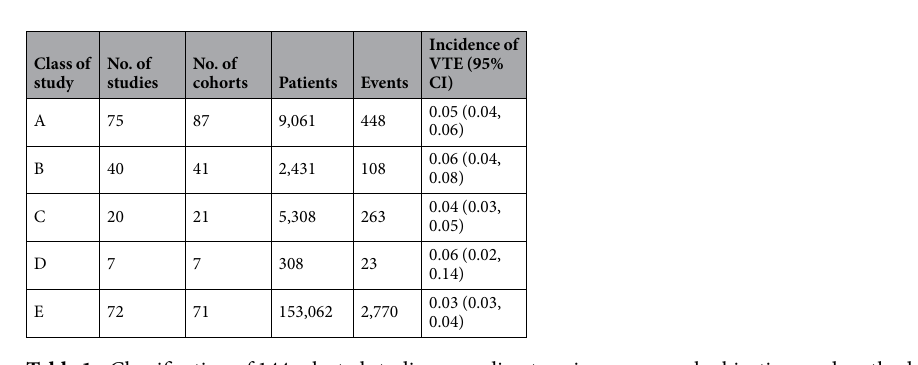
Table 1. Classification of 144 selected studies according to primary research objectives and methodological design. A indicates all prospective studies comprising B, C, D. B indicates prospective studies evaluating the outcomes of clinical therapeutic protocols describing VTE as a complication. C indicates prospective studies investigating the prevalence of clinical venous thrombotic events. D indicates prospective studies